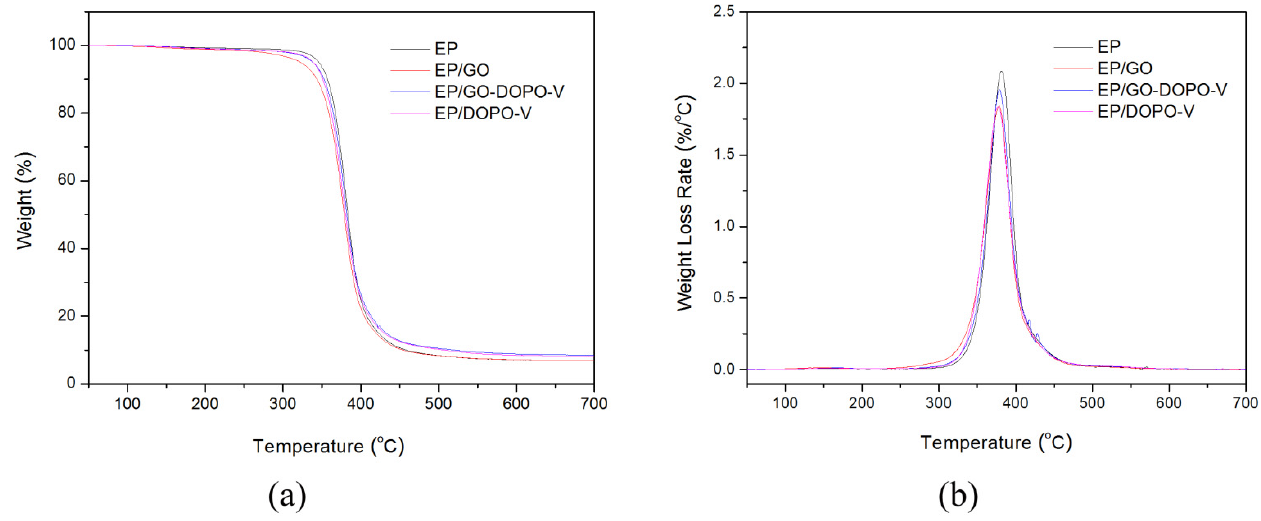
Figure 7. TGA ( a ) and DTG ( b ) curves of EP, EP/GO, EP/DOPO-V and EP/GO-DOPO-V. Table 1. TGA data of EP, EP/GO, EP/DOPO-V and EP/GO-DOPO-V.